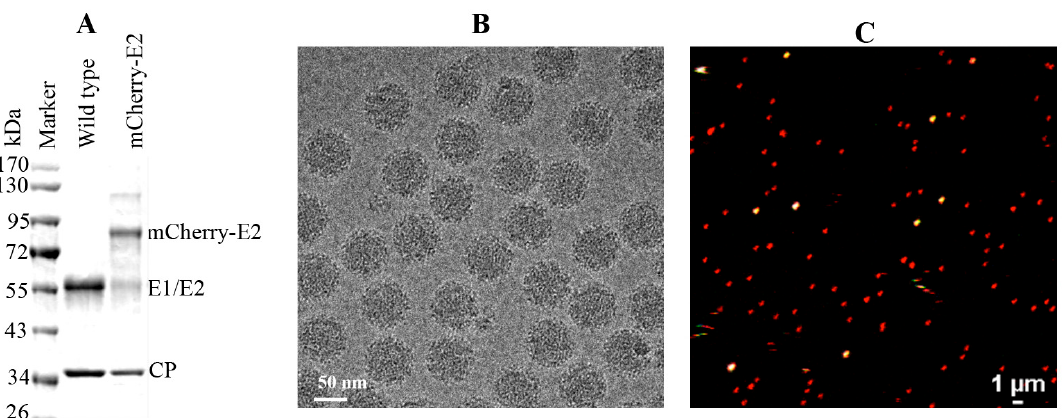
Figure 2. ( A ) Sodium dodecyl sulfate polyacrylamide gel electrophoresis (SDS-PAGE) analysis of purified WT and mCherry-E2 virus showing the size difference of mCherry protein tagged to the E2 and WT E2 protein; ( B ) Cryo-electron microscopy (CryoEM) of purified mCherry-E2 virus exhibiting uniform spherical morphology; ( C ) Confocal merged image of purified mCherry-E2 virus mixed with tetra speck beads (100 nm size fluorescent microspheres fluoresce in green, red, and blue channels, seen as white dots when merged) demonstrating that the individual virions can be observed by confocal live imaging.